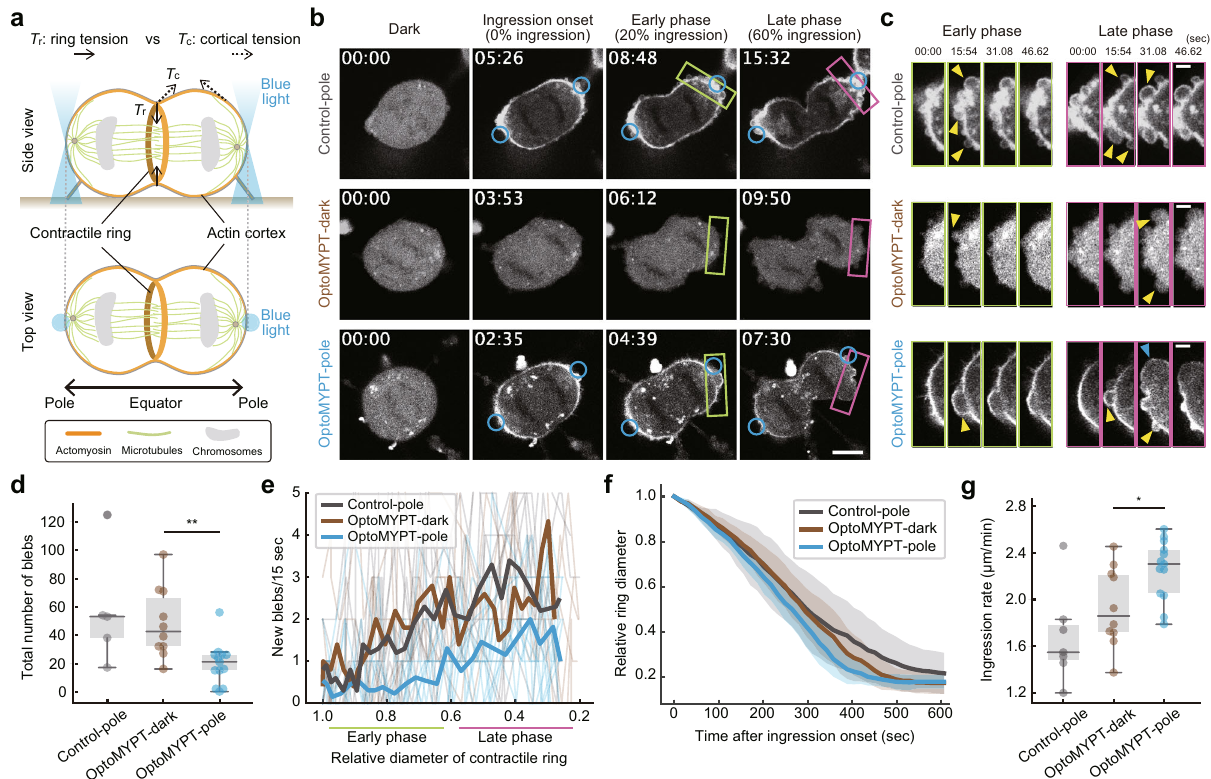
Fig. 4 Examination of the actomyosin-based cortical tension during cytokinesis with OptoMYPT. a Schematic illustration of cytokinesis in animal cells. Solid and dashed arrows indicate ring tension and cortical tension, respectively. Orange, green, and gray objects indicate actomyosin, microtubules, and chromosomes, respectively. Blue light is focused on the poles on both sides. b Representative images of SspB-mScarlet-I (upper) or SspB-mScarlet-I- MYPT169 (middle and lower) in MDCK cells during cytokinesis. The blue circular regions were locally illuminated with blue light every 3.11 s. Middle panels represent the cytokinesis of a cell under dark conditions. Scale bar, 10 μ m. c Inset images of polar blebbing (the green and magenta boxed regions in panel b , representing the early and late phases, respectively). Yellow and blue arrowheads indicate small and large new blebs per stack, respectively. Scale bar, 3 μ m. d , e Quanti fi cation of the total number of blebs during cytokinesis, shown as a box plot ( d ), and of the number of new blebs emerged within 15.54 s, shown as a line graph ( e ), in which thin and bold lines indicate individual and averaged data, respectively. n = 5, 10, and 13 cells for Control-pole, OptoMYPT-dark, and OptoMYPT-pole, respectively. ** p = 0.002 (two-tailed Student ’ s t test). f , g Quanti fi cation of the furrow ingression rate after ingression onset. Averaged relative diameters are plotted as a function of time with the SD ( f ). The ingression rate was estimated by calculating the slope of the ingression rate from 1.0 to 0.6 in panel f , and shown as a box plot ( g ). n = 7, 10, and 13 cells for Control-pole, OptoMYPT-dark, and OptoMYPT-pole, respectively. * p = 0.017 (two-tailed Student ’ s t